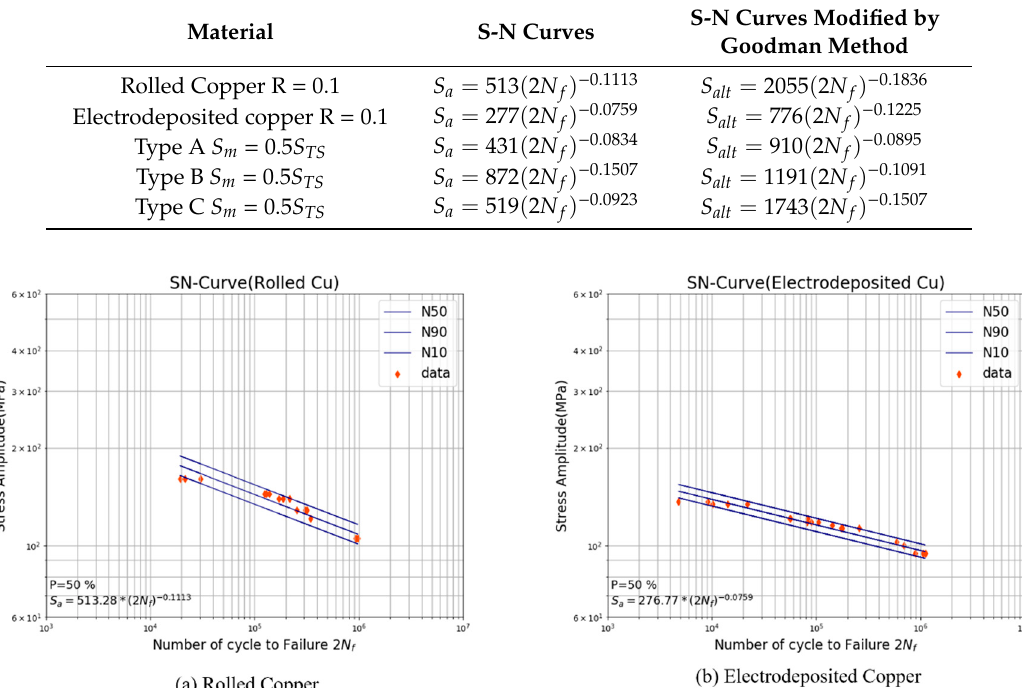
Figure 11. P-S-N curve from fatigue test for Cu thin films depending on process method.